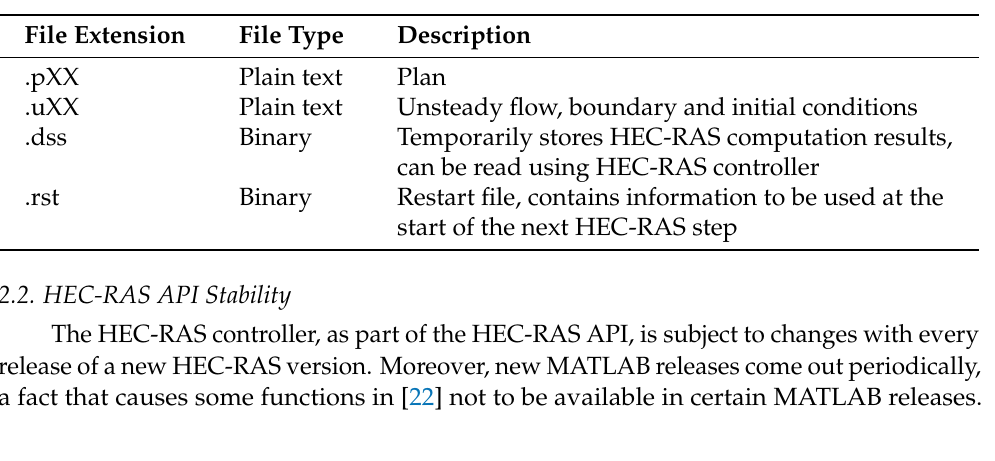
Table 1. List of important HEC-RAS